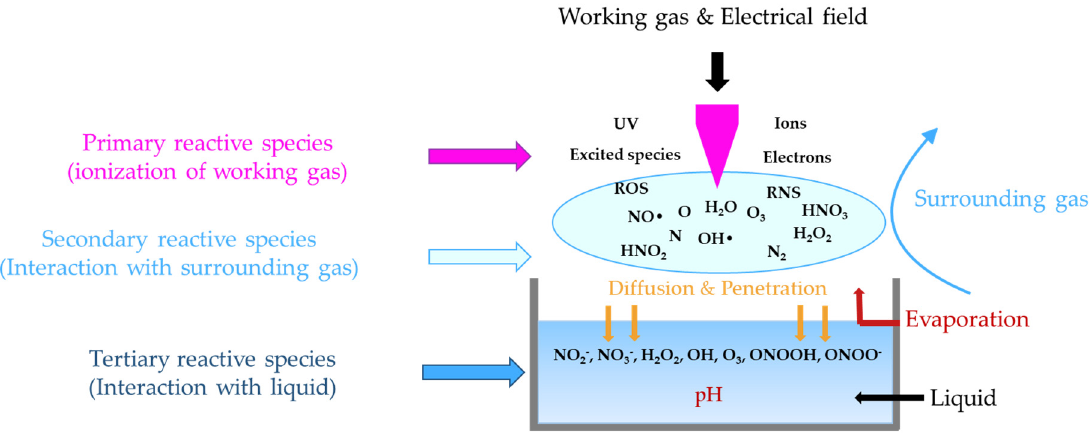
Figure 2. Schematic diagram of the synthesis mechanisms for plasma-liquid interaction (adapted from [61]).